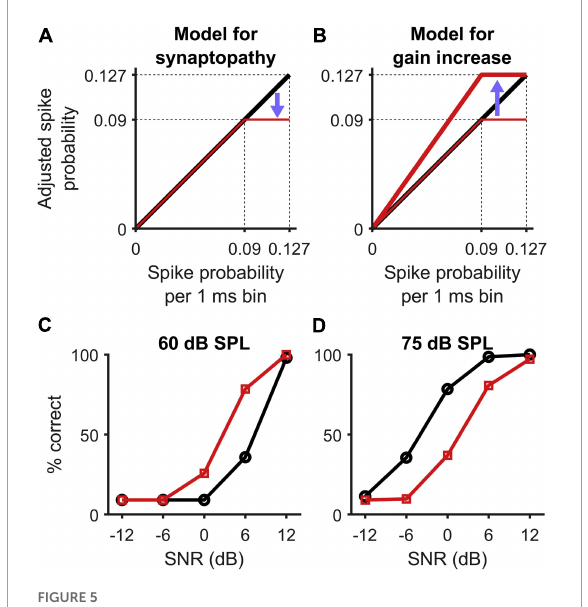
FIGURE5 Figure adapted from Monaghan et al. (2020) presenting a model for synaptopathy and central gain activation. (A) The loss of high-threshold auditory nerve fibers in cochlear synaptopathy saturates the spiking probability of neurons in the inferior colliculus at supra-threshold level. (B) Central gain activation presents a multiplicative increase of the neurons sensitivity to restore the maximum (non-synaptopathic) spike probability. (C,D) As a consequence, the slope of the spike probability function increases in mid-levels, which leads to better discriminability from the HHL model (squares) than from the control model (circles) at 60 dB SPL, but reduced discriminability at 75 dB